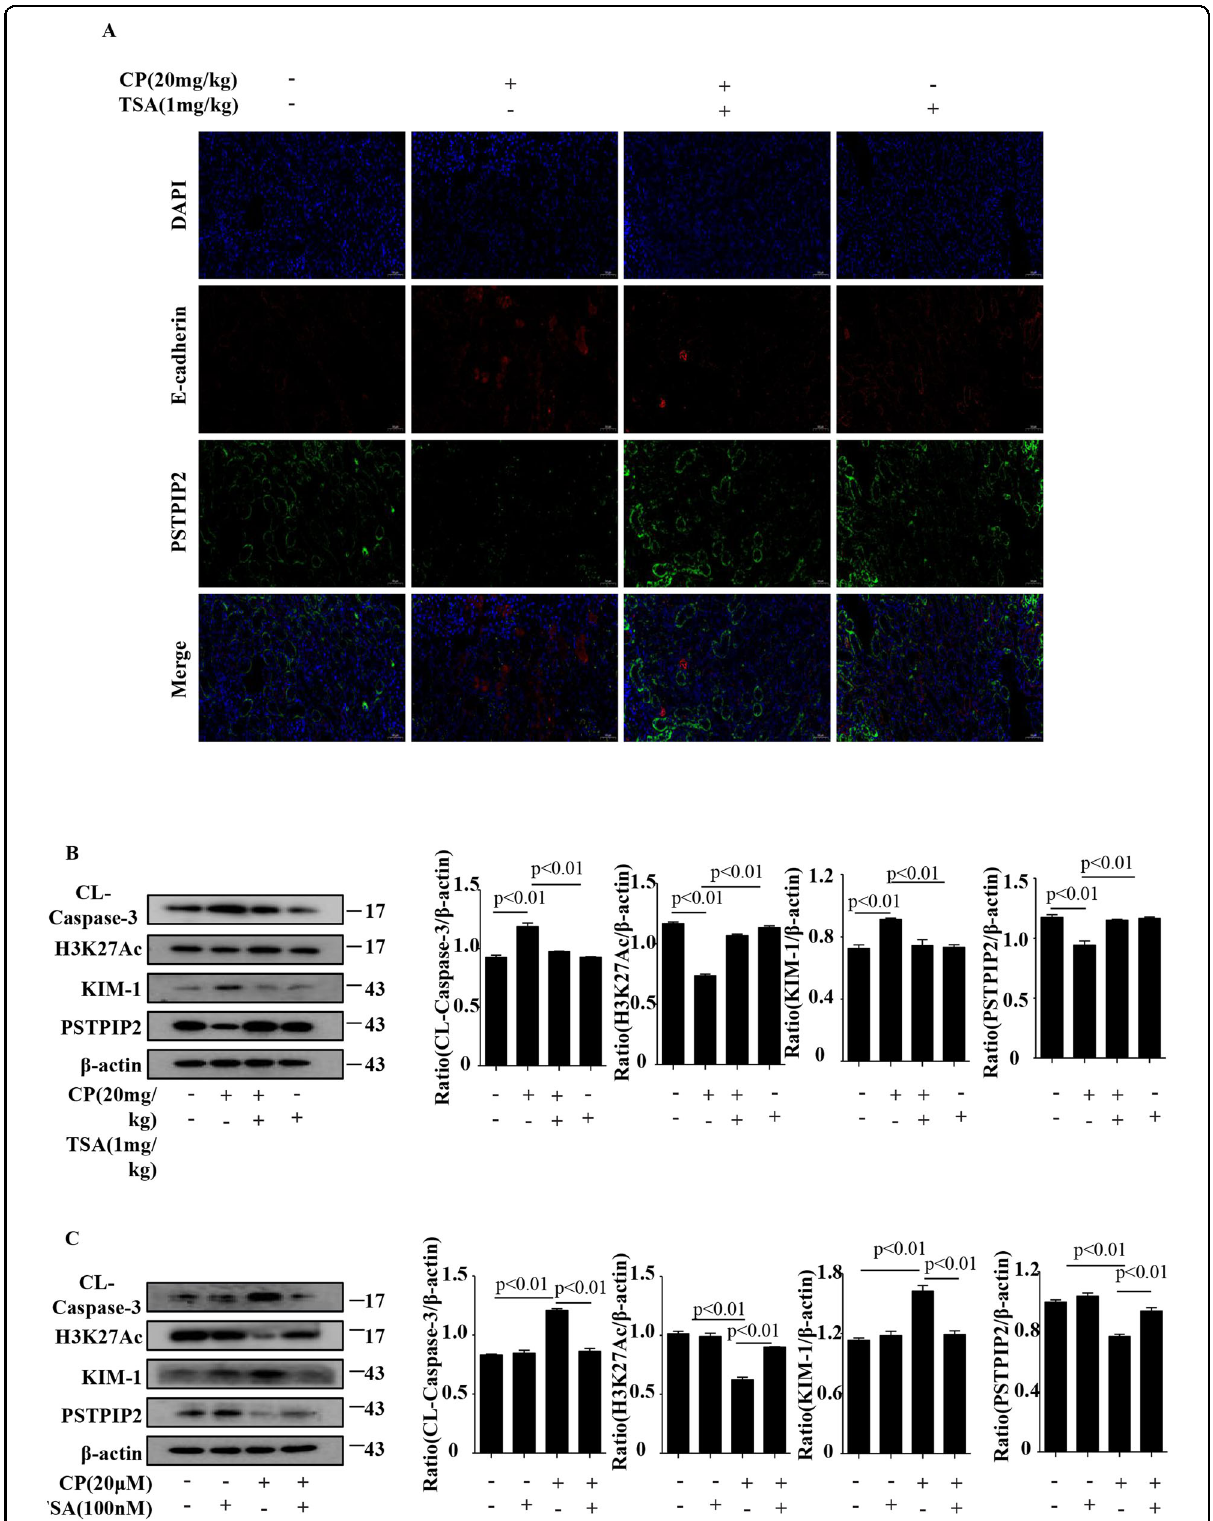
Fig. 7 HDAC inhibitors protect from AKI by regulating the expression of PSTPIP2. a Immunohistochemical localisation of PSTPIP2 expression in the kidney tissues. Scale bar, 50 μ M; magni fi cation, 20×. b The expression of cleaved caspase-3, H3K27Ac, KIM-1 and PSTPIP2 detected by western blot in CP-treated AKI mice administered with TSA. c The expression of cleaved caspase-3, H3K27Ac, KIM-1 and PSTPIP2 detected by western blot in CP- treated HK-2 cells treated with TSA. Similar results were obtained in 3 independent experiments with 10 mice per group or in triplicate culture